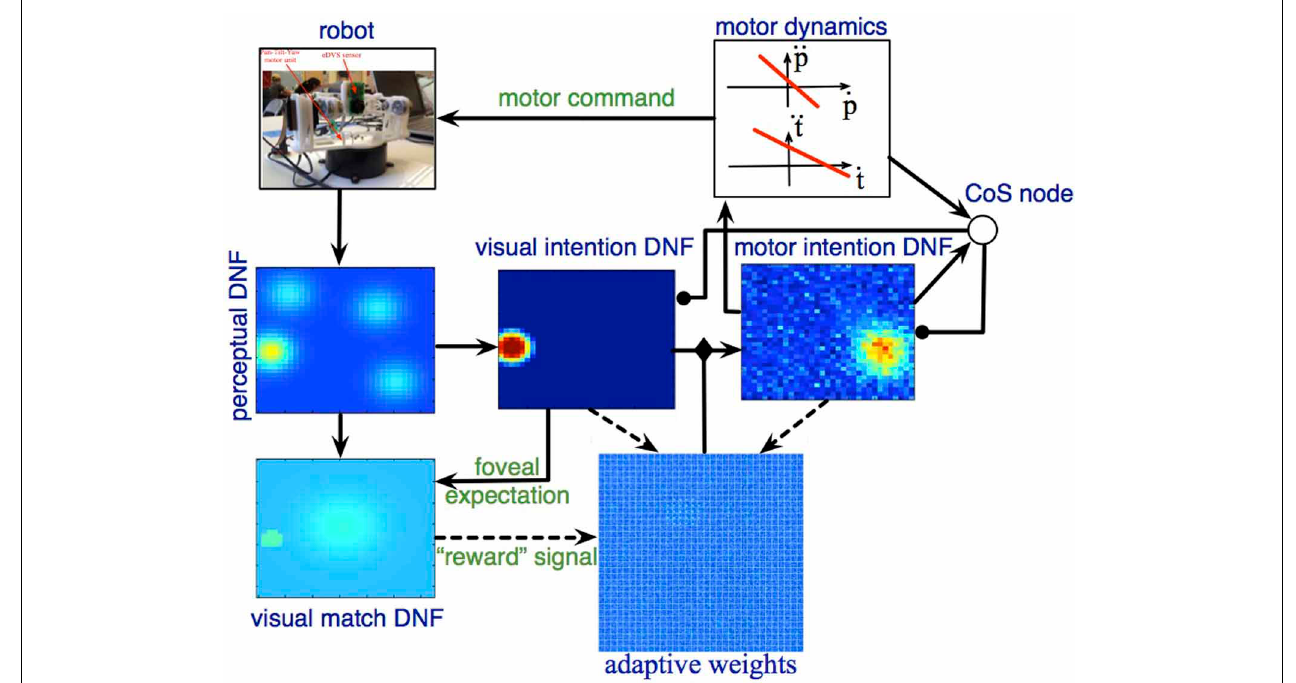
FIGURE 6 | The DFT architecture for autonomous looking and learning the sensorimotor map. The robotic camera provides input to the perceptual DNF, which performs initial segregation of object-like regions in the visual stream. The visual intention DNF selects and stabilizes the spatial representation (in visual coordinates) of a single target for the upcoming looking action. Through adaptive weights, the visual intention DNF provides